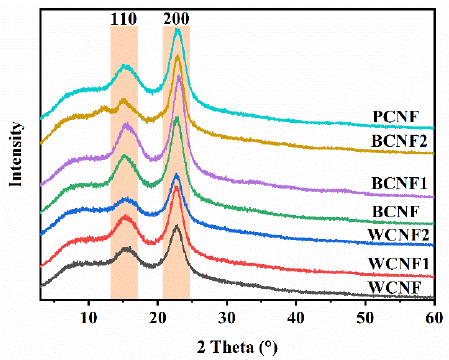
Figure 6. X-ray diffraction patterns of TEMPO-oxidized CNFs.